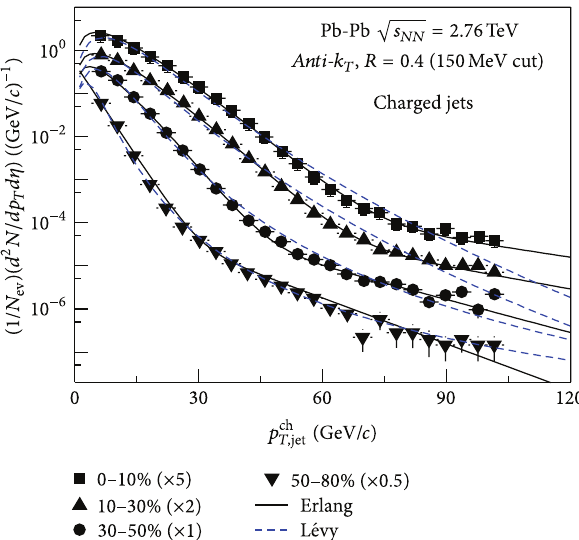
Figure 5: The 𝑝 𝑇 spectrums of charged jets produced in Pb-Pb collisions at √𝑠 𝑁𝑁 = 2.76 TeV. The symbols represent experimental data of the ALICE Collaboration [14]. The solid and dashed curves represent results calculated by the multicomponent Erlang distribution and the L´evy distribution, respectively.